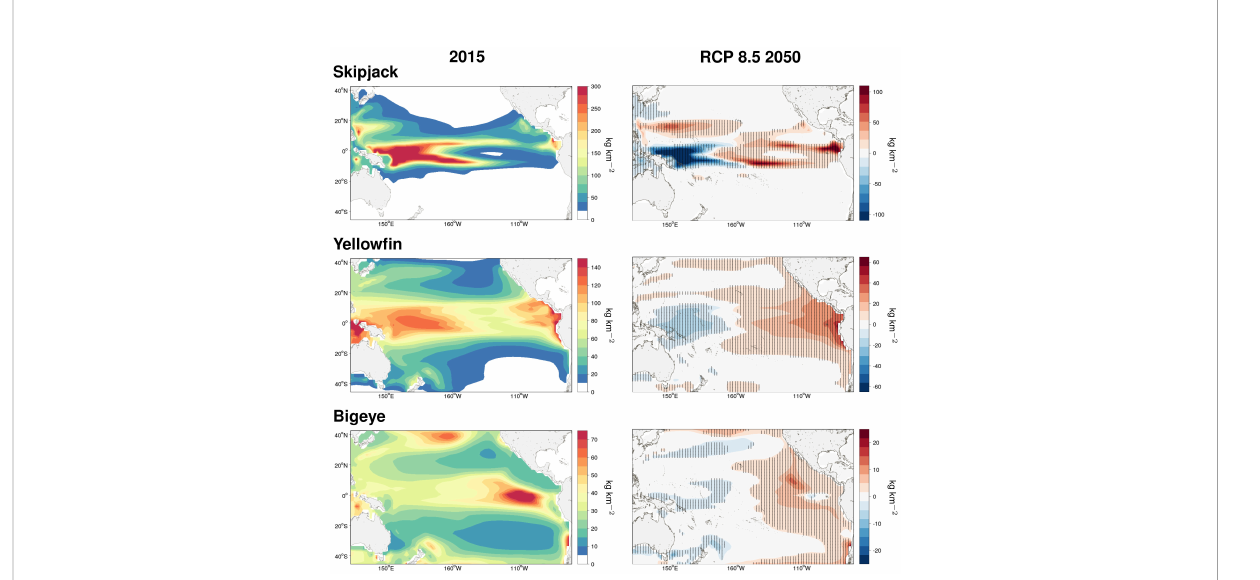
FIGURE 1 Average biomass distributions (kgkm – 2 ) of skipjack, yellow fi n and bigeye tuna in the Paci fi c Ocean basin for 2015 (2011 − 2020) (left), and mean anomalies (kgkm – 2 ) from the average 2015 biomass distribution of each tuna species projected to occur by 2050 (2044 − 2053) under the RCP 8.5 greenhouse gas emissions scenario (right). Shading indicates areas where projections from four Earth System Models agree in the sign of change. Source: Bell et al.